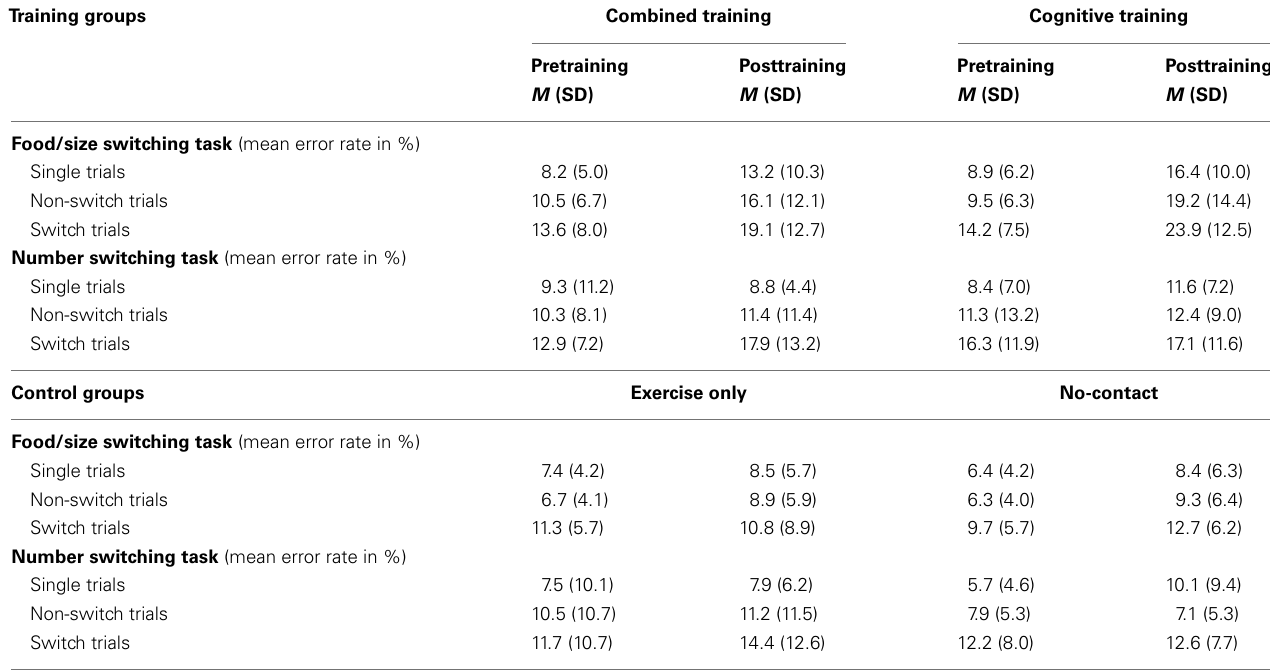
TableA2 | Mean error data for transfer task switching tasks in the training groups (combined and cognitive training only) and control groups (exercise only and